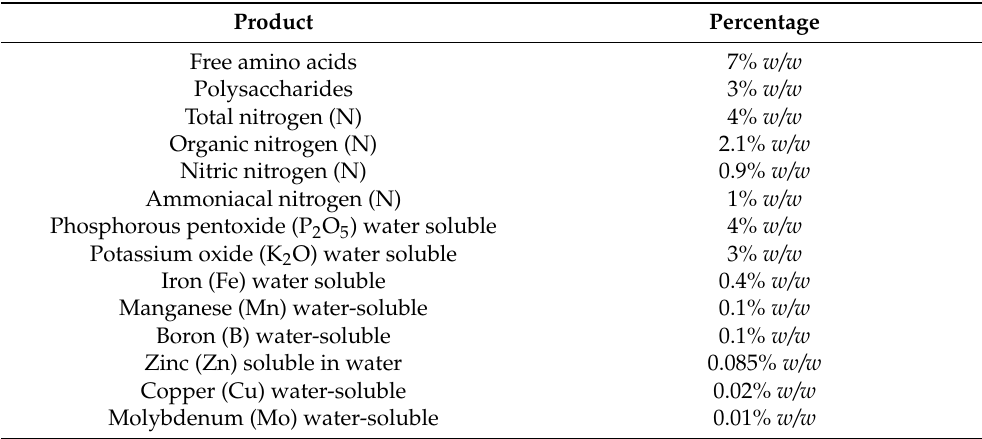
Table 1. Constituents of RAZORMIN ® presented by the manufacturer on the product label. Percent- age is presented with respect to 1.24 kg net mass and 1 L product